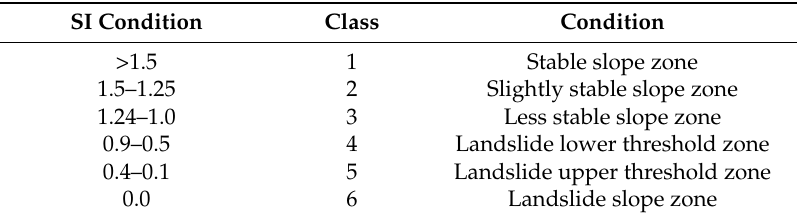
Table 1. Classes as per the soil stability index. SI : stability index.